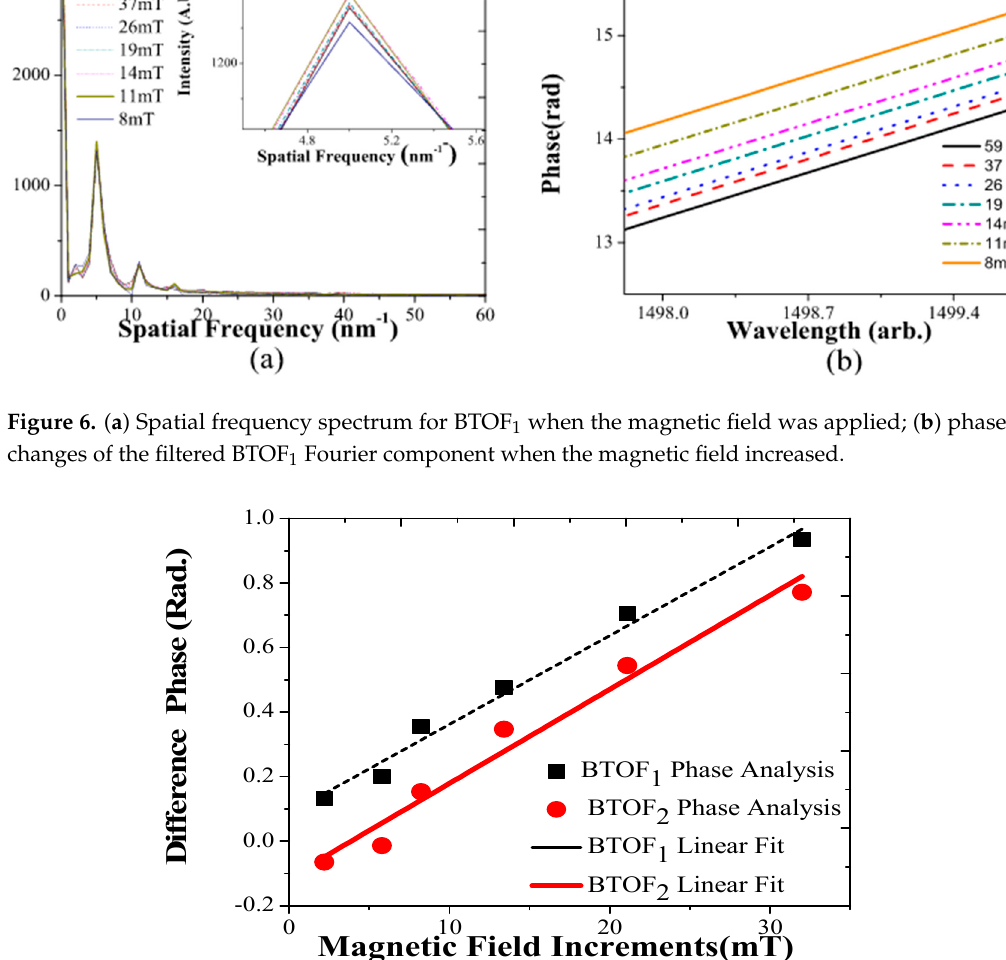
Figure 7. Difference phase analysis of both BTOFs for magnetic field increments.